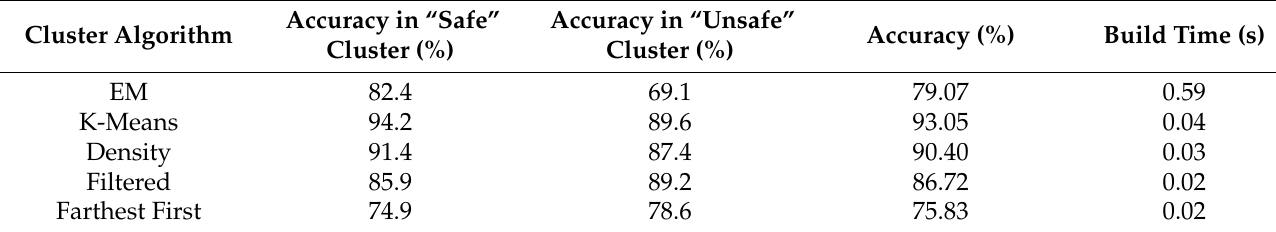
Table 6. Accuracy and build time for each cluster.